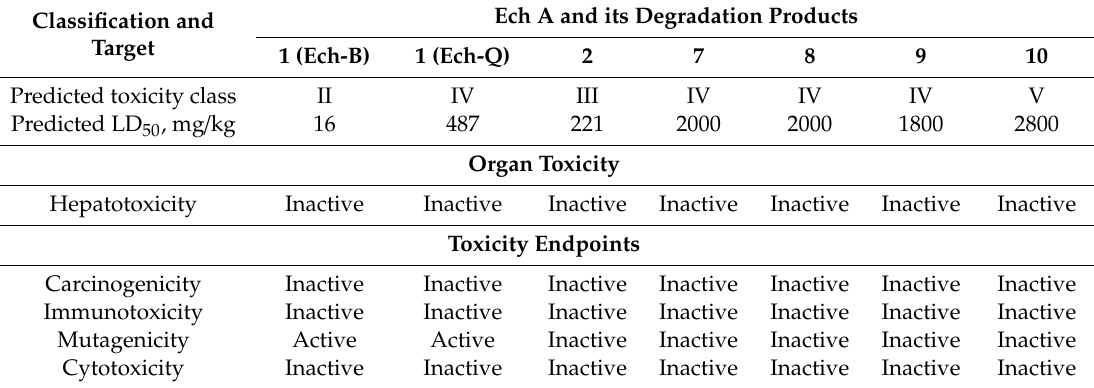
Table 4. Oral toxicity prediction results for Ech A and its degradation products. LD 50 , median lethal dose.